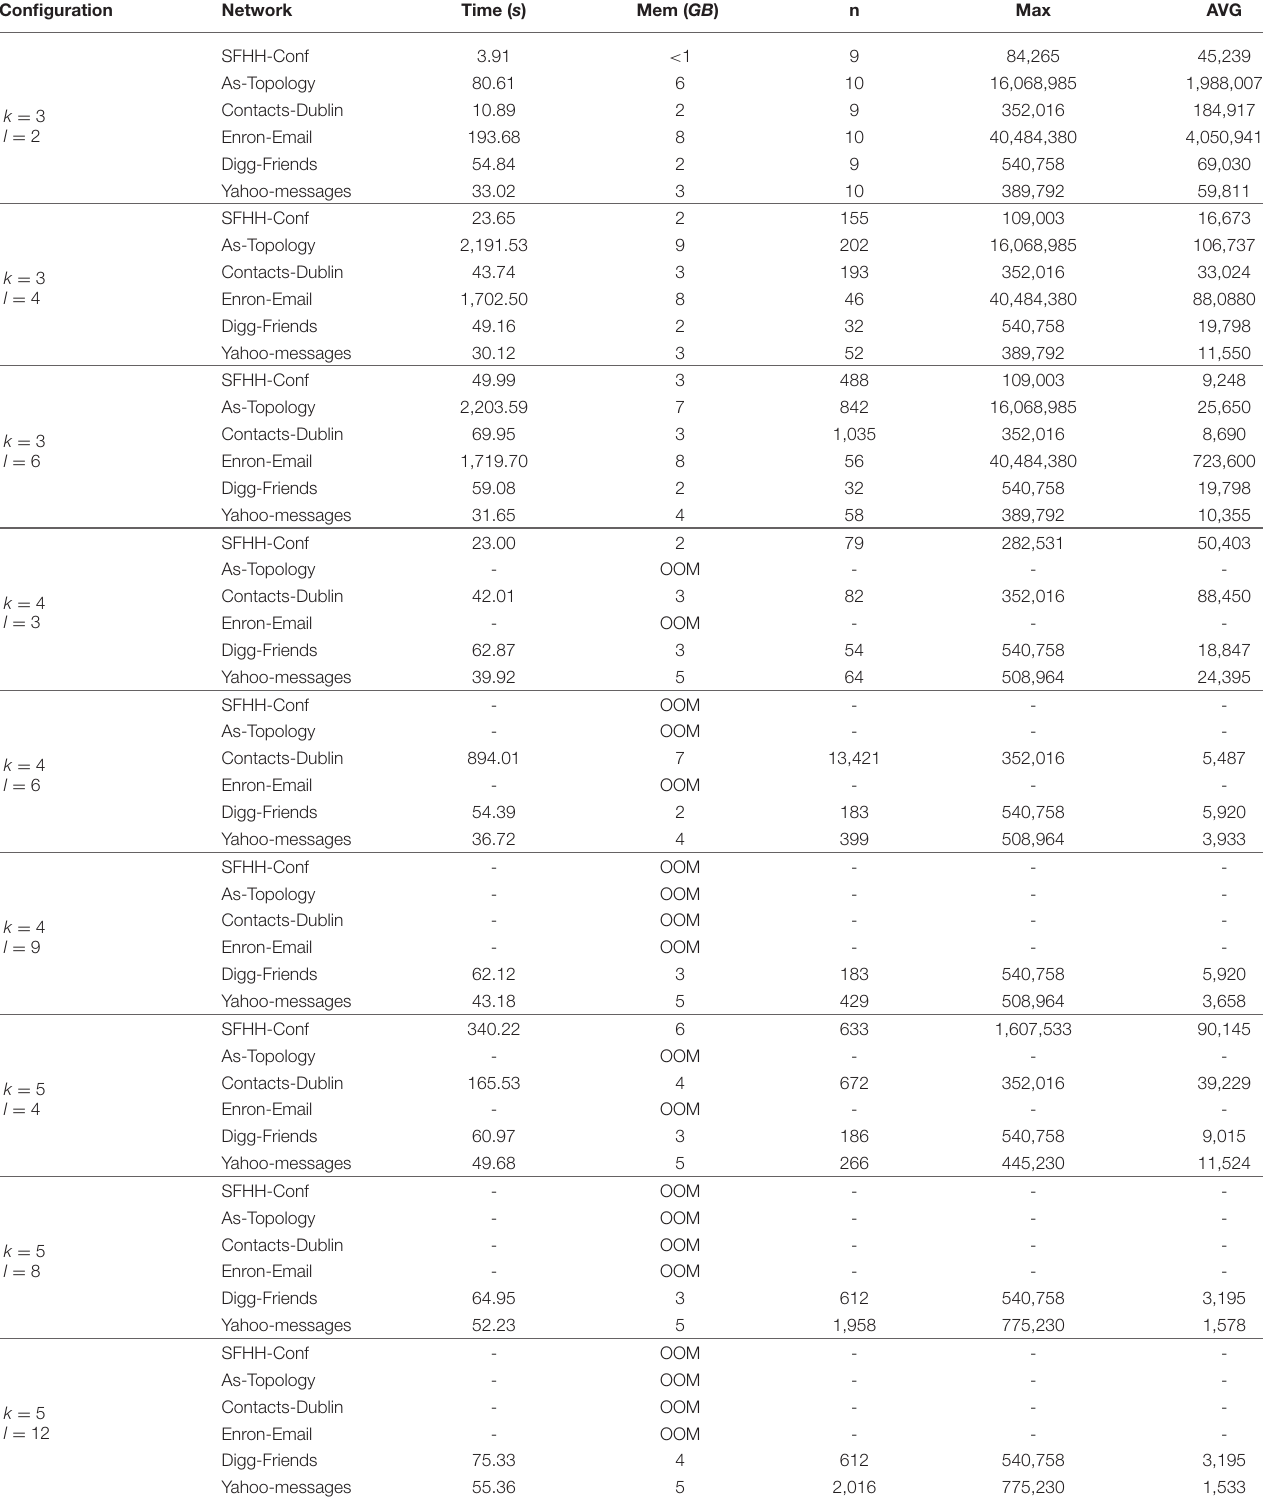
TABLE 3 | Experiments on Dataset 1 with 1 = 3 r and different combination of values of k and l .